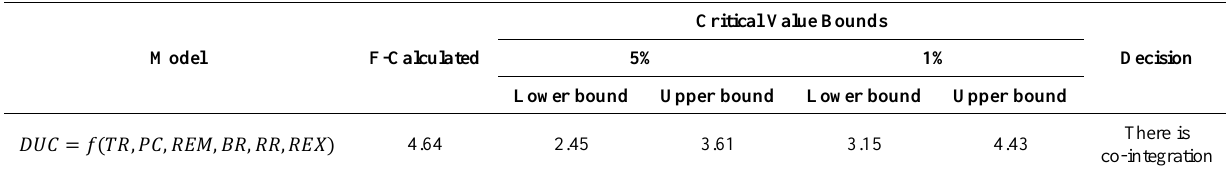
Table 2. Bounds Co-integration